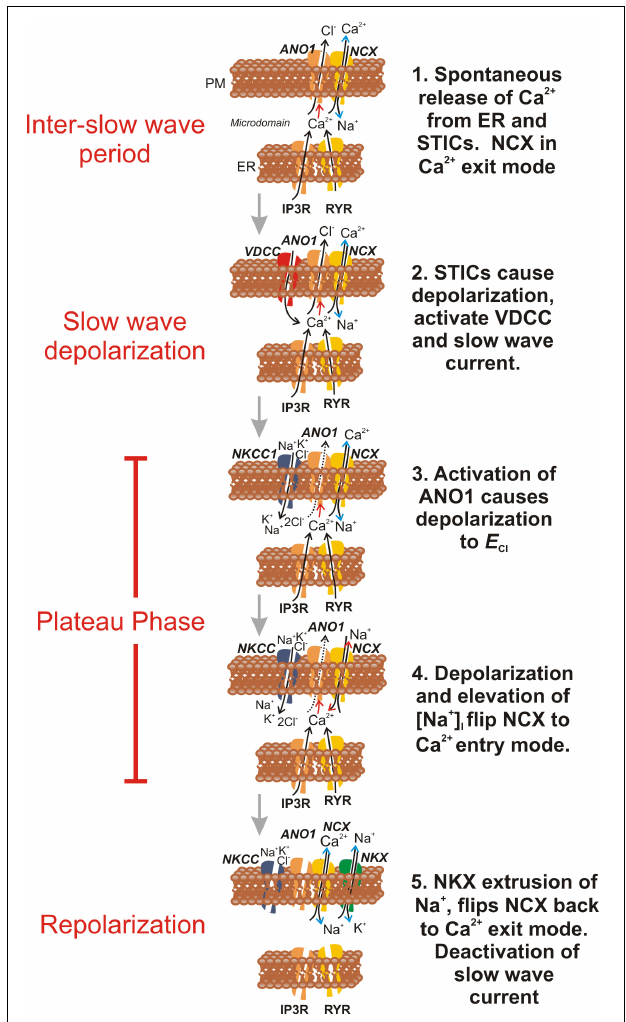
FIGURE 12 | Schematic proposing how NCX contributes to ionic currents and fluxes during the slow wave cycle in ICC. This figure summarizes how the activity of NCX might be integrated with other known ionic mechanisms involved in generation of pacemaker activity in ICC. Electronmicroscopy has demonstrated close apposition between the plasma membrane and ER, and the restricted volumes formed are termed microdomains. Each frame in the schematic is a temporal representation of a typical microdomain, and ionic concentrations in the restricted volumes of the pacemaker units are hypothesized from current and previous findings. For simplicity, ion channels and transporters appear or disappear in individual frames as their role waxes and wanes. Frame 1 shows the period of the inter-slow wave interval. Stochastic Ca 2 + release events from the ER trigger (Red arrow) activation of ANO1 channels in the plasma membrane (PM), activating STICs. Following a Ca 2 + transient, NCX, operating in Ca 2 + exit mode (Blue arrow heads), and SERCA (not shown) rapidly restore basal [Ca 2 + ] i within the microdomain, reducing open probability of ANO1 channels and limiting the duration of STICs. Frame 2 During the interval between slow waves, the probability of STICs increases with time (Hirst and Edwards, 2001). Summation of STDs (voltage response to STICs) causes activation of voltage-dependent (T-type) Ca 2 + current (VDCC) (Zheng et al., 2014). Ca 2 + entry triggers Ca 2 + -induced Ca 2 + release in many microdomains in synchrony and activation of whole cell CaCC currents, known as the slow wave current (Zhu et al., 2009). Ca 2 + entry and Cl − efflux cause depolarization close to E Cl (Kito et al., 2005). In